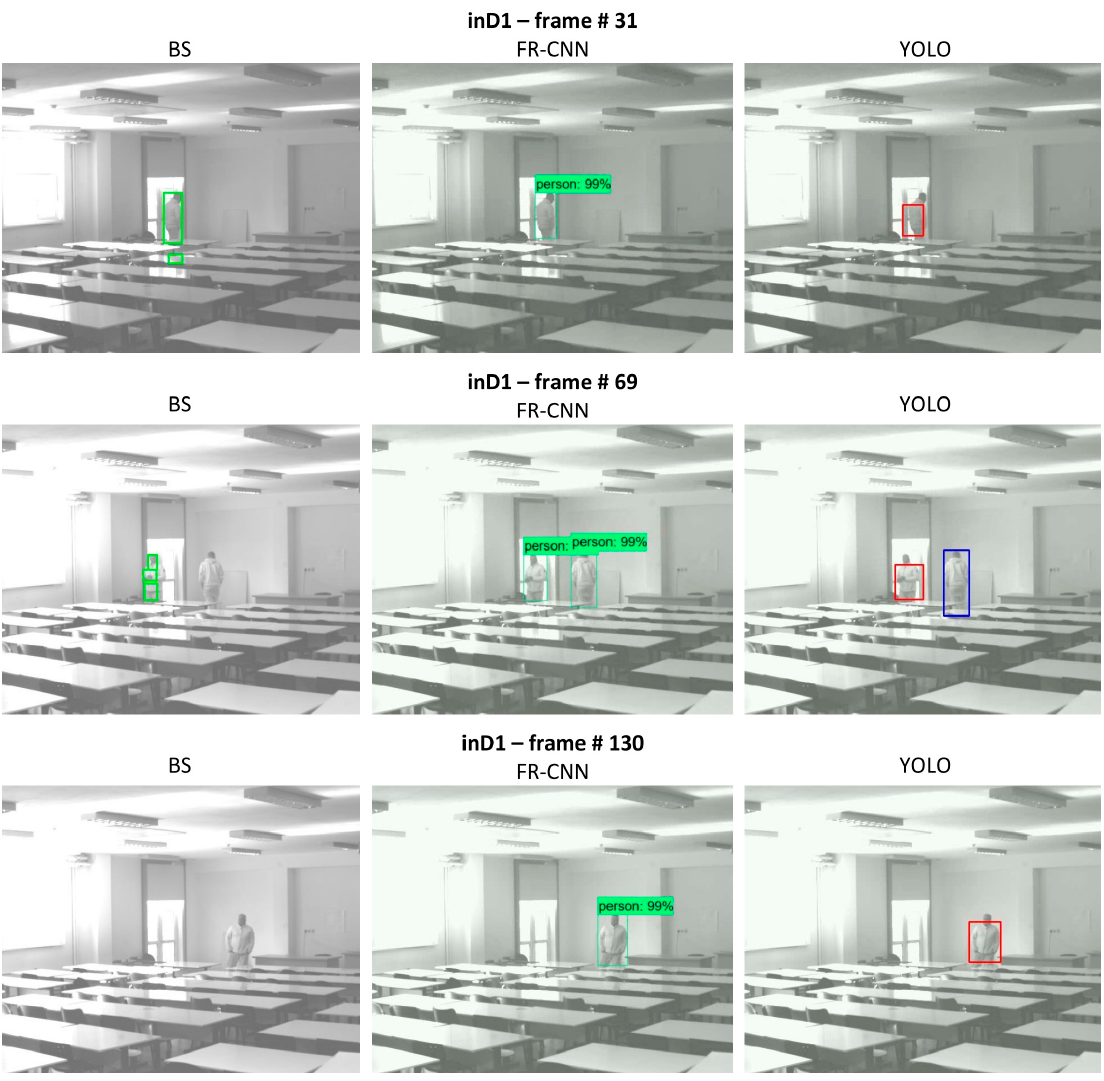
Figure 11. Indicative detection examples overlaid onto the SWIR data for the first indoor dataset (inD1) based on the integrated BS, FR-CNN, and YOLO detectors.